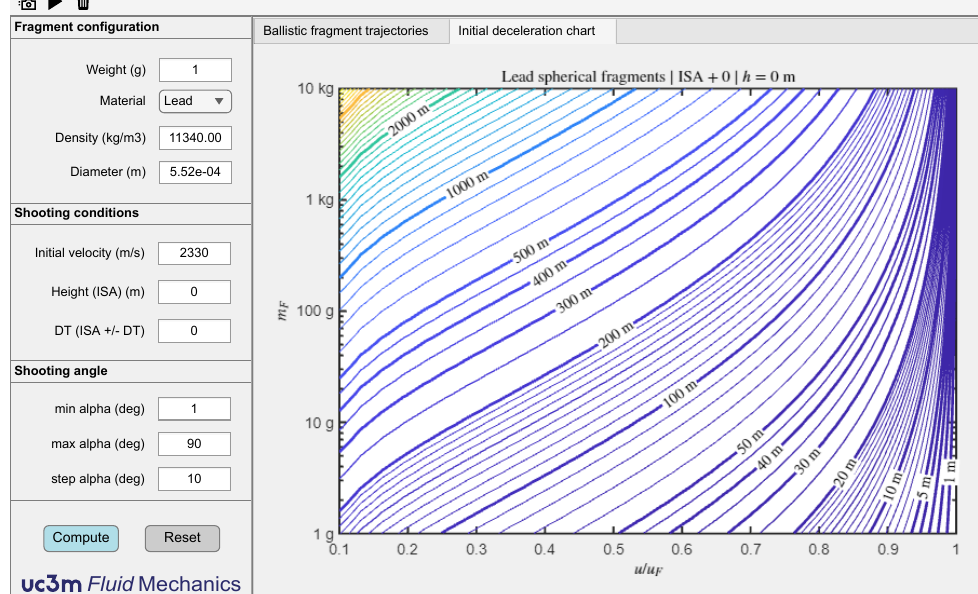
Figure 7. Interface of the primary fragment calculation assistant showing the initial deceleration chart, which provides the fraction of the initial velocity, u / u f , achieved at a certain distance (contour lines), given the fragment mass, m f , and material (e.g., lead), and the atmospheric conditions (e.g., ISA mean sea level). Fragments are assumed spherical.